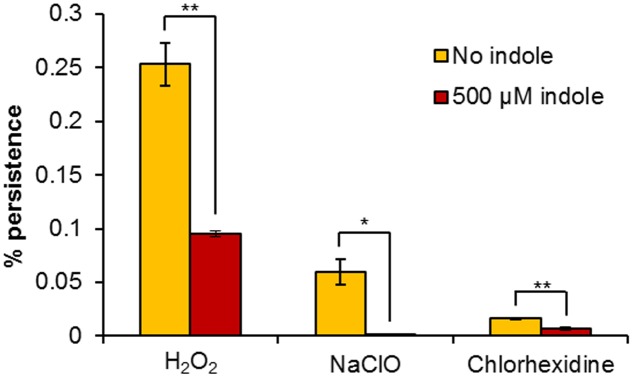
Influence of exogenous indole on H. volcanii persistence. Percentage survival of H. volcanii pre-incubated for 1 h with or without 500 μM indole, prior to 6 h challenge with biocidal concentrations of H2O2, NaClO, and chlorhexidine. Plotted values are the mean of triplicate measurements and error bars represent ± SD. Asterisks denote significance values as determined by paired t-tests: ∗p < 0.05; ∗∗p < 0.01; ∗∗∗p < 0.001.